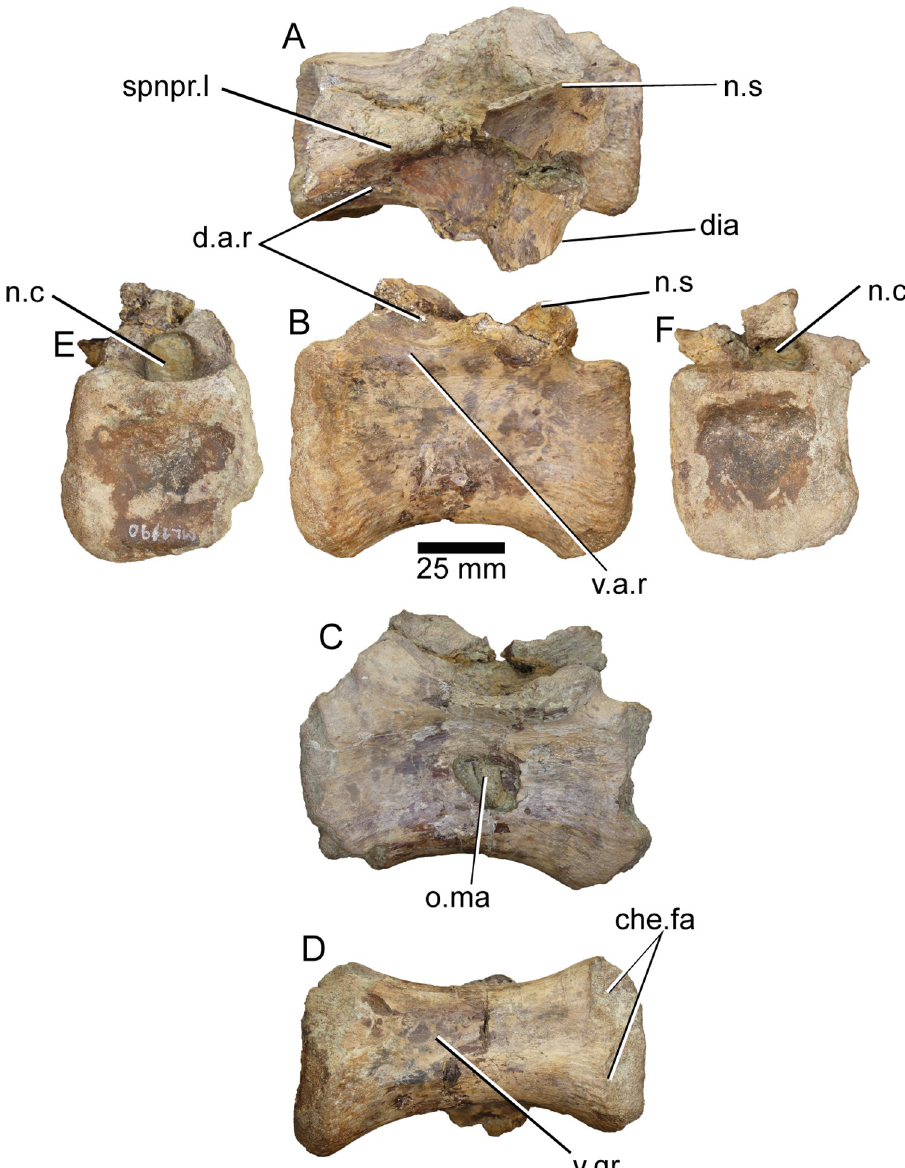
Fig 17. Caudal vertebra of Iberospinus natarioi (ML1190-18). A , dorsal, B, C; lateral, D , ventral, E , anterior, and F, posterior view. che.fa , chevron facets, d.a.r , dorsal anterior ridge, dia , diaphysis, n.s , broken neural spine, n.c , neural canal, o.ma , oval mark, spnpr.l , spinoprezygapophyseal lamina, v.a.r , ventral anterior ridge, v.gr , ventral